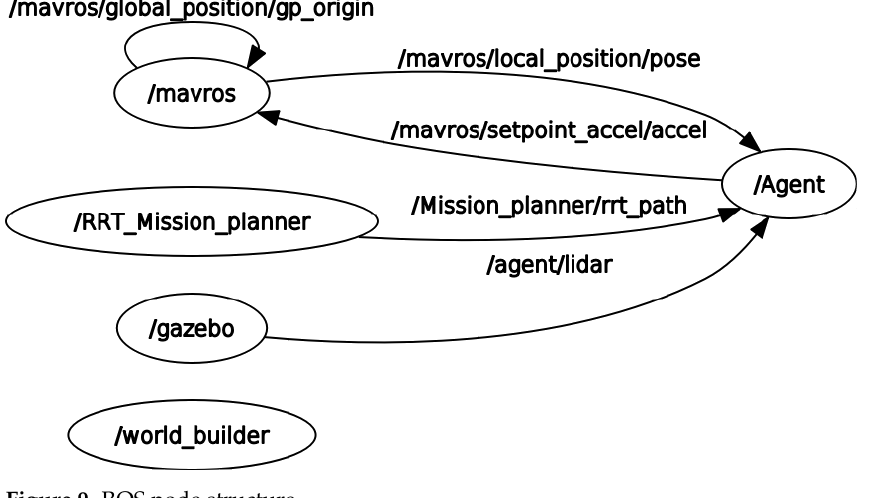
Figure 9. ROS node structure.